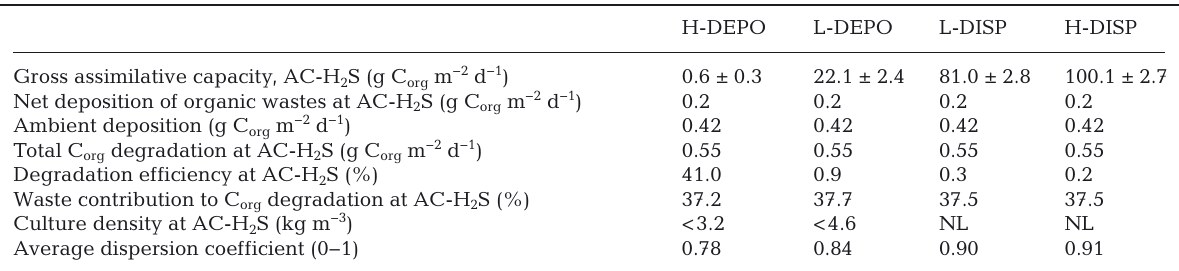
Table 5. Assimilative capacity of organic wastes that prevent sulfide concentration >1500 µM in surface sediments (upper 2 cm) (AC-H 2 S). Degradation efficiency represents how much is predicted to be locally degraded in sediments in relation to gross waste deposition, the remaining fraction being resuspended, buried or accumulated in sediments by the end of the fish farm cycle. H-DEPO and L-DEPO: high and low deposition; L-DISP and H-DISP: low and high dispersion. NL: no limit based on AC-H 2 S